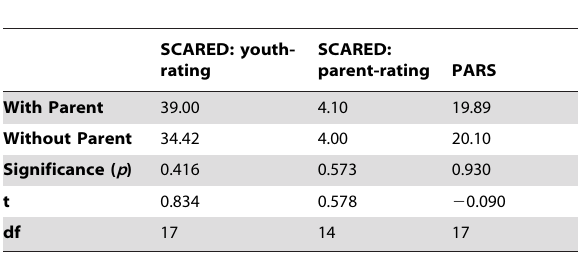
Table 2. Symptom contrast of anxiety severity scores SCARED (youth and parent rating) and PARS between anxious groups.